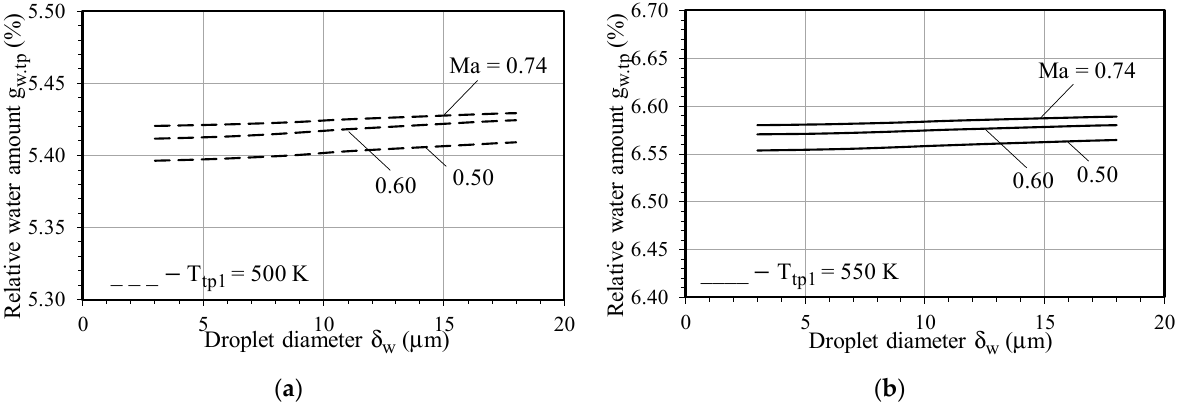
Figure 9. Dependences of the relative amount of water evaporated in the air flow, g w , on the droplet diameter, δ w , at different air temperatures at the inlet: ( a ) at T tp1 = 500 K and ( b ) at T tp1 = 550 K. For effective heat transfer between phases, it is necessary to maintain the maximum value of the relative temperature at the outlet of the thermopressor. That is, at the beginning of the process of spraying water for more intense evaporation, the Mach number should reach the maximum values for a subsonic flow Ma = 0.95. However, the increase in Mach numbers continues in the process of liquid evaporation, which is associated with an increase in the vapor-air flow density. This fact should be taken into account when designing the thermopressor flow paths to prevent the flow from going to supersonic speeds. For the investigated evaporation chamber at the initial air flow temperature T tp1 = 500 K, the Mach number increases by 11% and reaches the value of Ma = 0.85–0.92; at T tp1 = 550 K, the Mach number increases by 12% and reaches the value of Ma = 0.71–0.83. The main characteristics of the water evaporation process in the low-flow thermopressor working chamber (G a = 1.0–1.5 kg/s), as obtained by mathematical modeling (Ma = 0.50), incomplete evaporation, it is possible to provide a droplet diameter of less than δ w = 20 µ m at the thermopressor outlet.